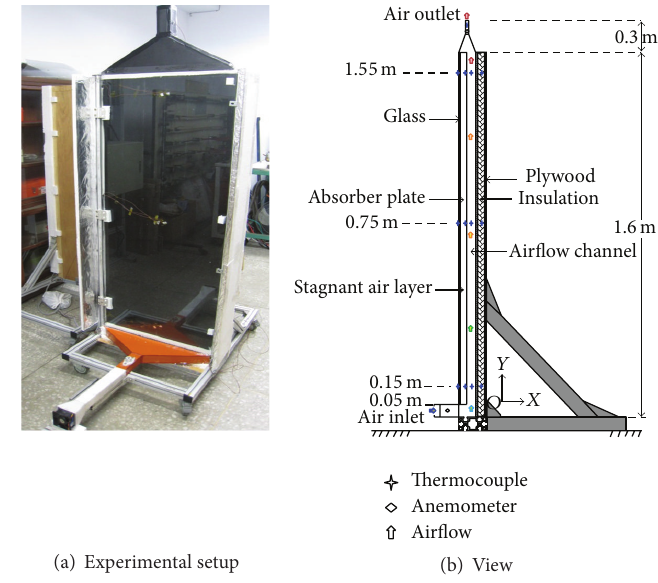
Figure 3: Schematic diagram of the experimental setup and view of the solar